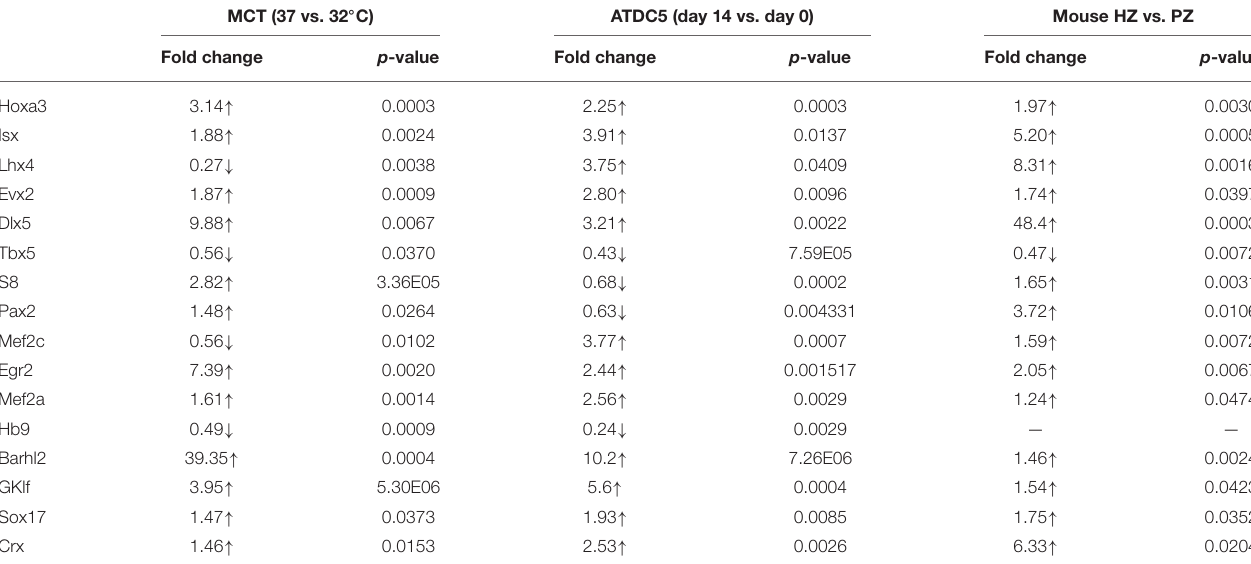
TABLE 2 | Fold changes in mRNA levels of candidate TFs in hypertrophic vs. proliferative